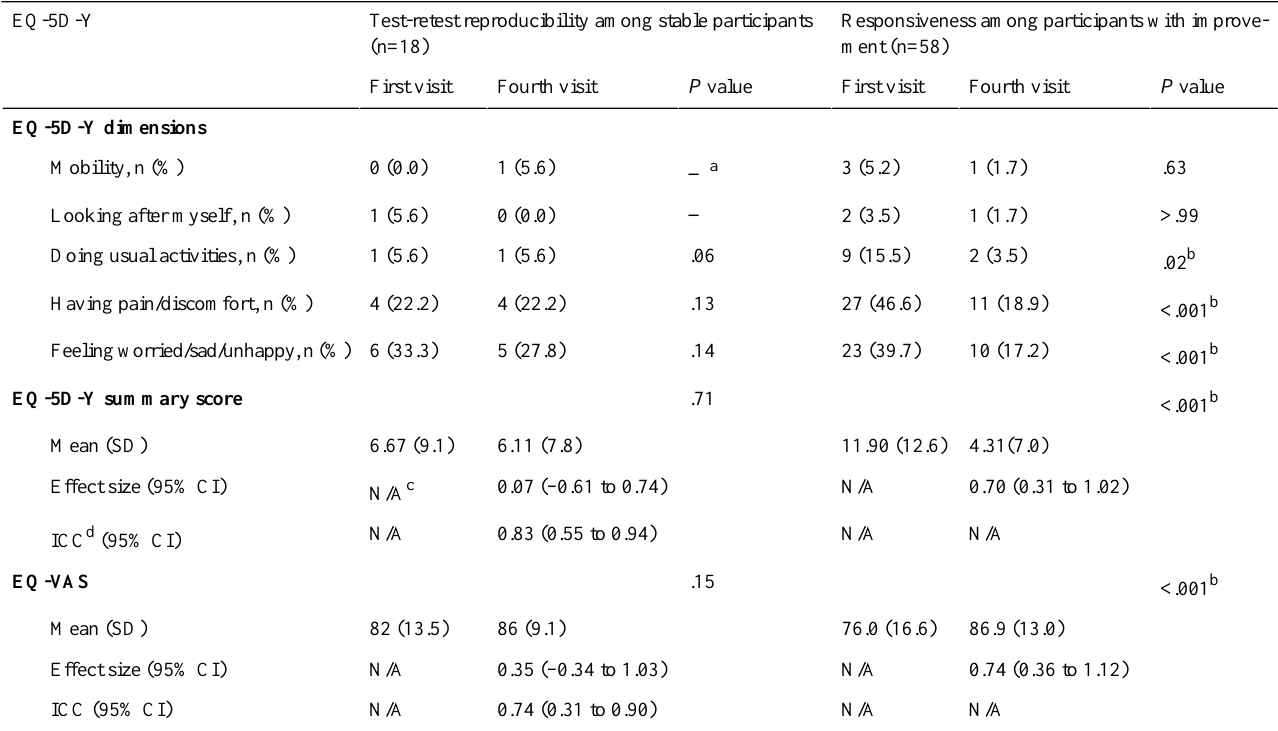
Table 7. Reproducibility and responsiveness of EuroQol-5D-Youth (EQ-5D-Y): problems reported by each dimension, summary score, and EuroQol-Visual Analog Scale (EQ-VAS) at the first and fourth